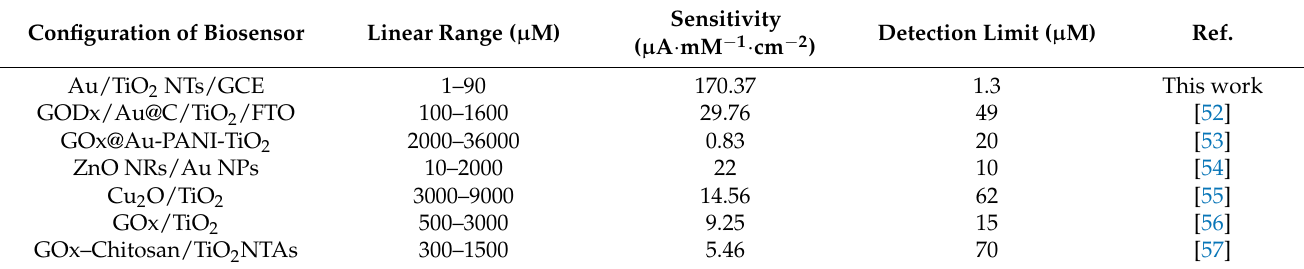
Figure 7. ( a ) Photocurrent curve in different concentrations of glucose, and ( b ) a corresponding calibration curve of the 0.5 wt.% Au/TiO 2 NTs electrode for the detection of glucose (1–90 µ M). Table 1. Comparison of analytical characteristics of different glucose sensors.